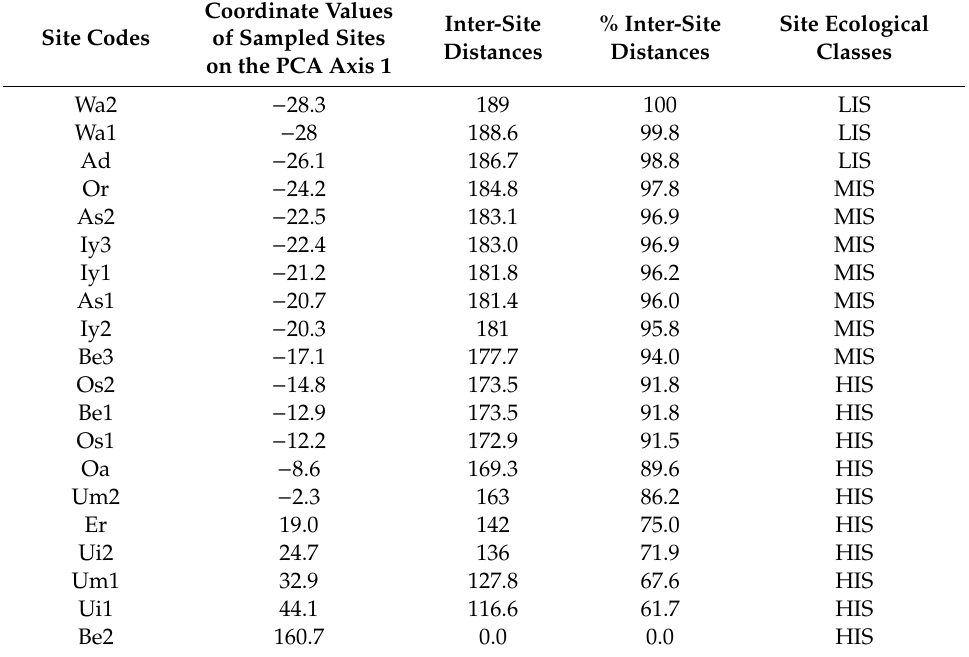
Table 1. Coordinate values of sites on the PCA first axis, inter-site distances, percentage inter-site distances and ecological categories of the sampled sites for the forested riverine systems within urban catchments. Abbreviations: Site Codes: Ad (Adfofi River), Wa1 (Warri River Site 1),Wa2 (Warri River Site 2), As1 (Ase River Site 1), As2 (Ase River Site 2), Iy1 (Iyiukwu River Site 1), Iy2 (Iyiukwu River